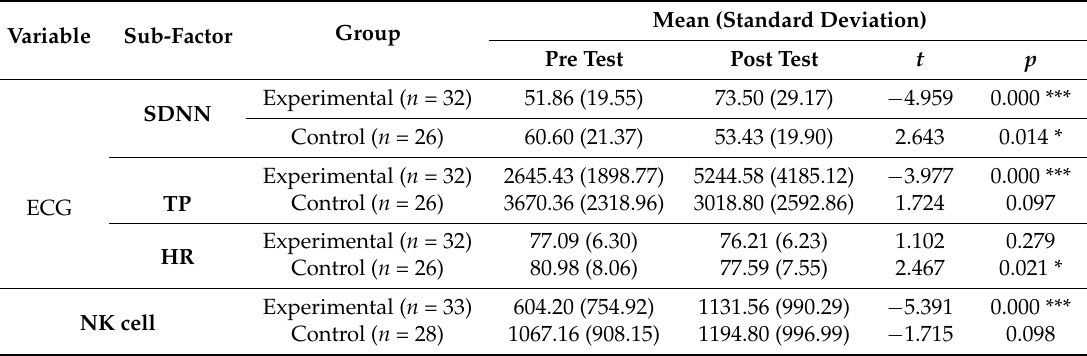
Table 3. Comparison of physiological variables pre-post test between experimental and control